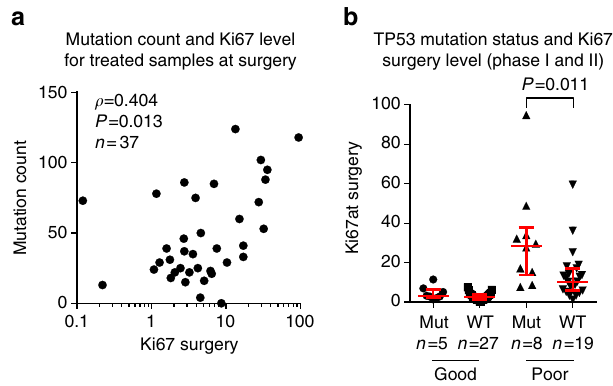
Figure 5 | Relation of mutations to Ki67. ( a ) Correlation of mutations counts to the Ki67 level was highest for treated samples at surgery. ( b ) On the combined set from phase I and phase II, the Ki67 level of poor responders was significantly higher for patients with mutated TP53 (mut) than wild-type TP53 (WT). This was not seen for good responders, although Ki67 level for TP53 -mutated patients was higher on baseline (Supplementary Fig. 11). Significance tested by Mann–Whitney test, red lines show median and interquartile ranges.